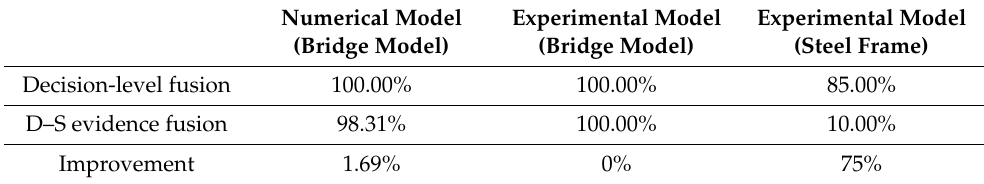
Table 8. Comparisons of the accuracy with the D–S evidence fusion.